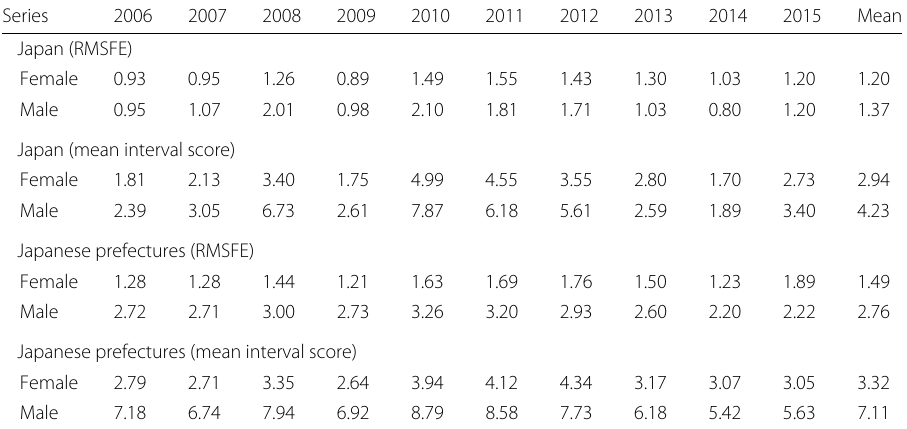
Table 7 Point and interval forecast accuracies for an existing model-averaged method averaged across the Japanese female and male national and sub-national mortality rates for ages between 60 and 100+. Forecast errors have been multiplied by 100. The results show its inferior point and interval forecast accuracies compared to the proposed two model averaging methods. This further confirms that one should not average all models, but a subset of all “good” models